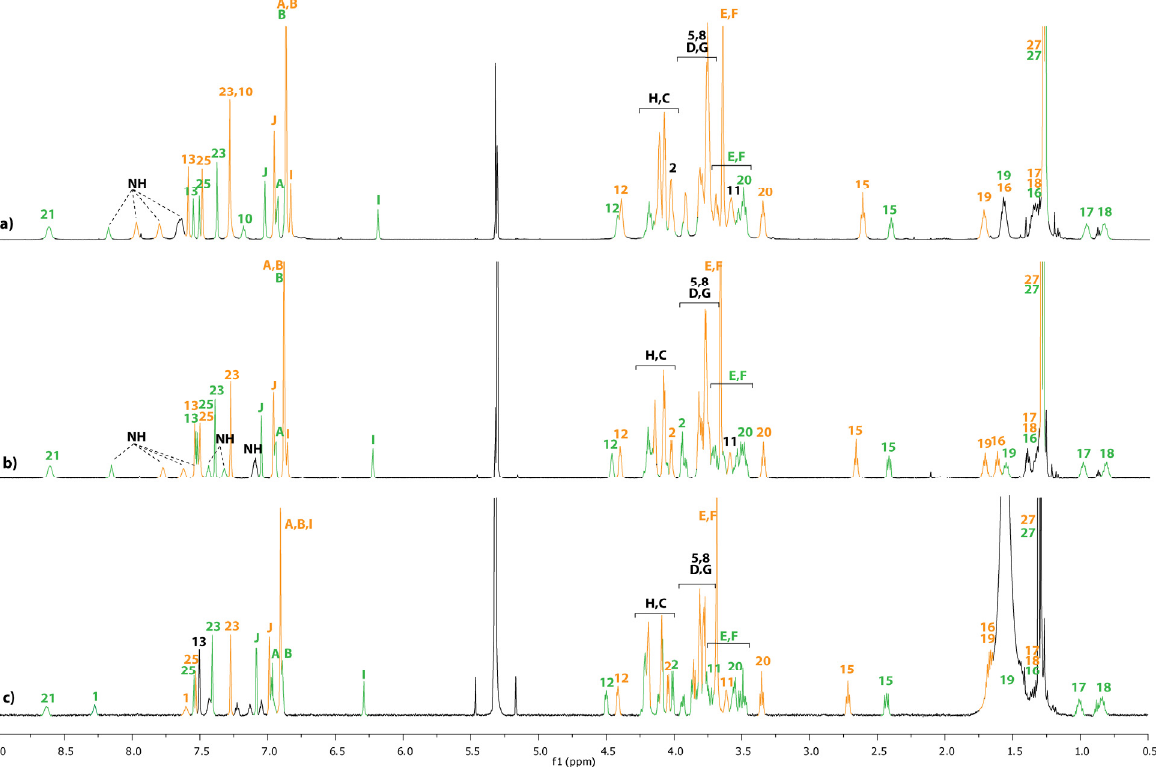
Figure 3. 1 H-NMR spectra (600 MHz, 298 K) of a mixture of compound 12/12u in CD at: ( a ) 5.10 − 2 M. ( b ) 5.10 − 3 M. ( c ) 5.10 − 4 M. The lettering and numbering correspond to the proton assignments indicated in scheme 1. The orange color corresponds to the unthreaded molecule 12u , whereas the green color corresponds to lasso compound 12 .